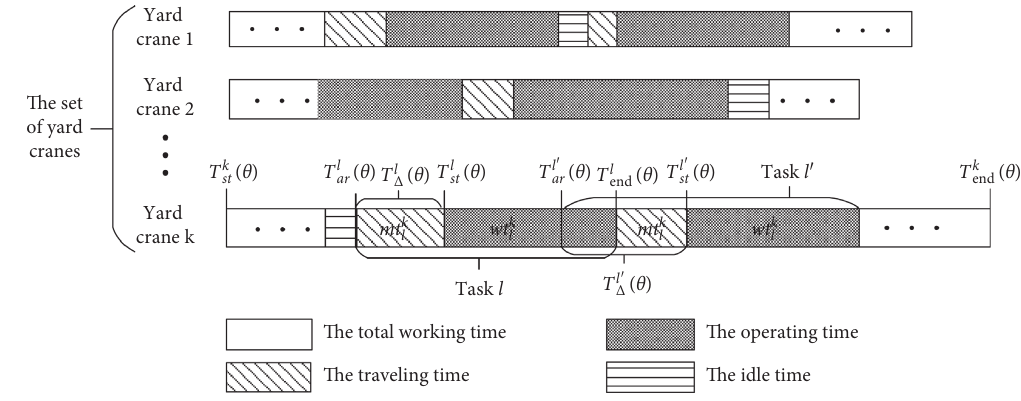
Figure 4: The time axis of yard cranes in scenario θ